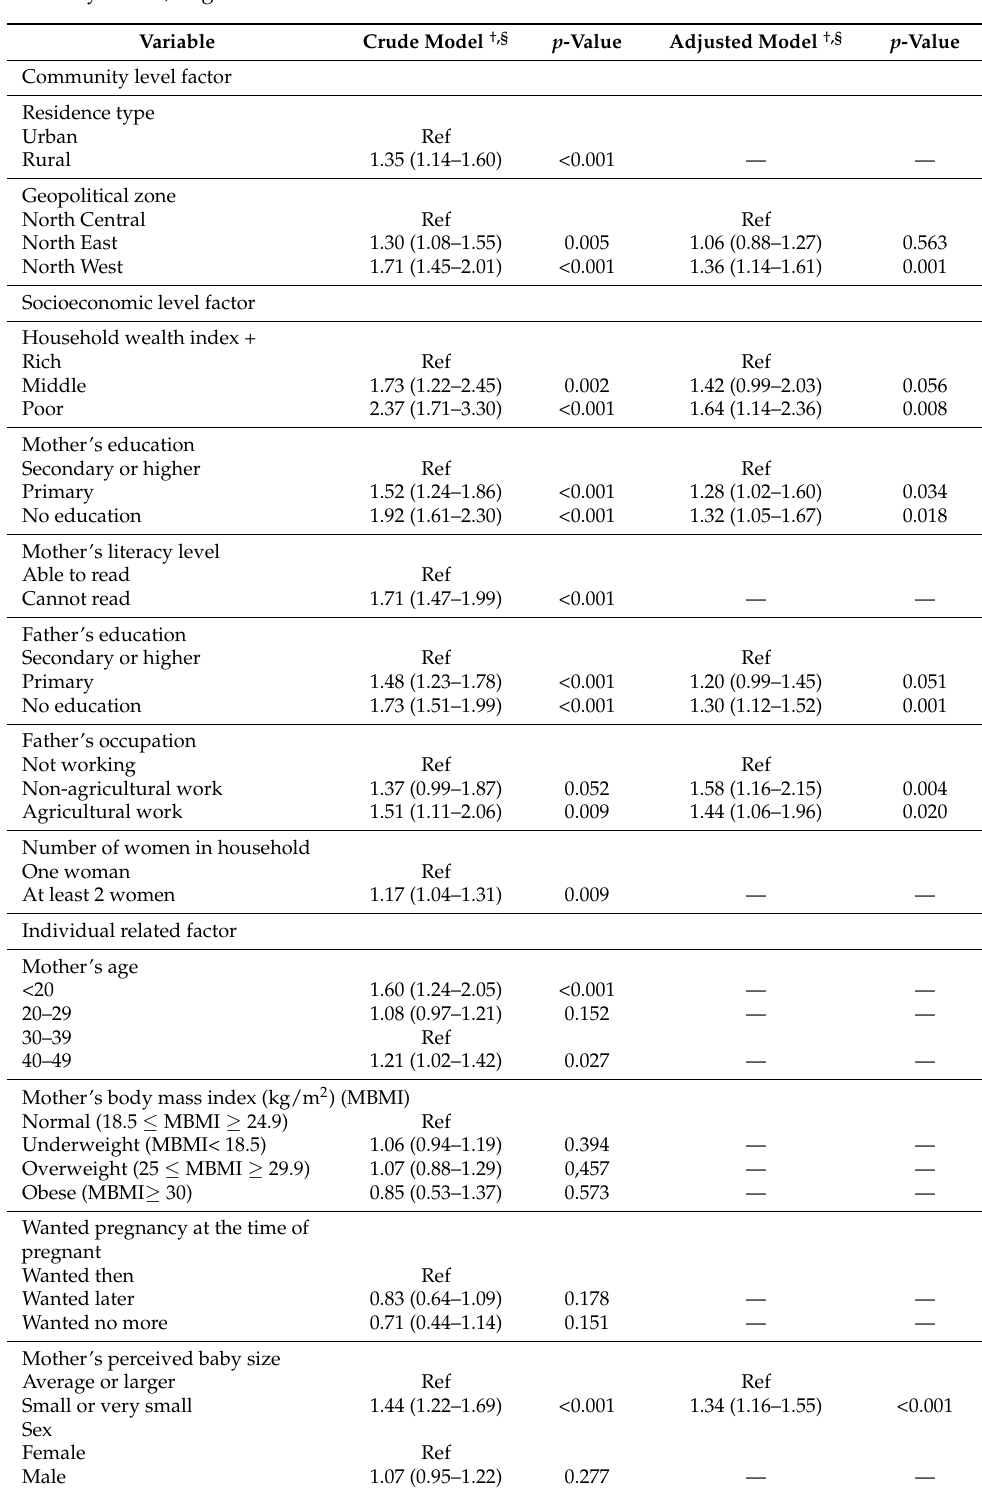
Table 3. Crude and adjusted odd ratios 95% confidence interval for factors related to under-5 mortality NGZs,